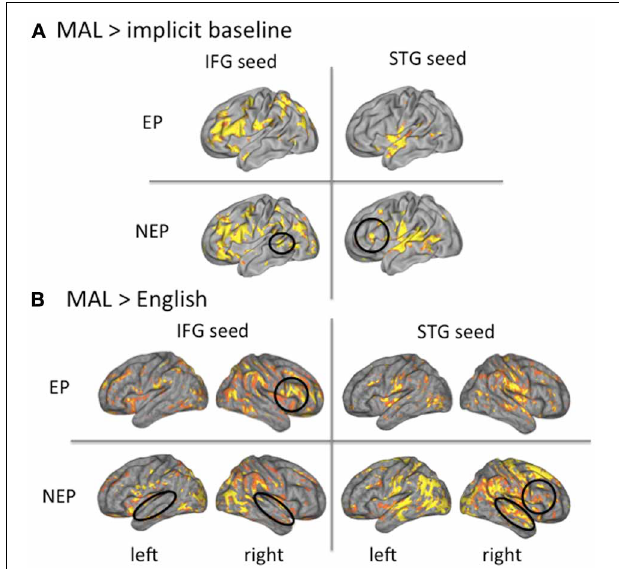
FIGURE 6 | Beta-series analysis. The left IFG is coactive with the STG for NEP but not EP learners (A) . The STG and IFG are more interactive as compared to English for NEP as compared to EP learners (B) .